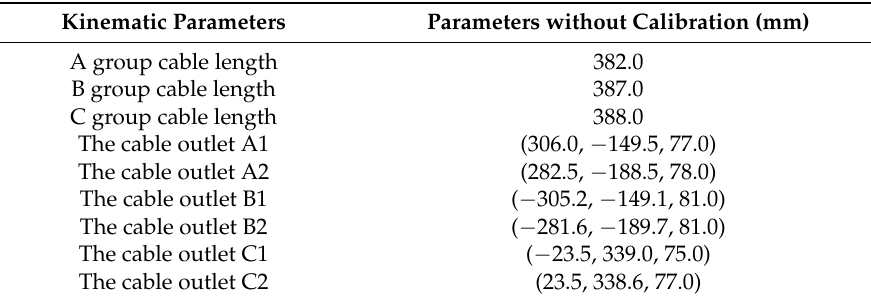
Table 3. The initial measurement of kinematic parameters.